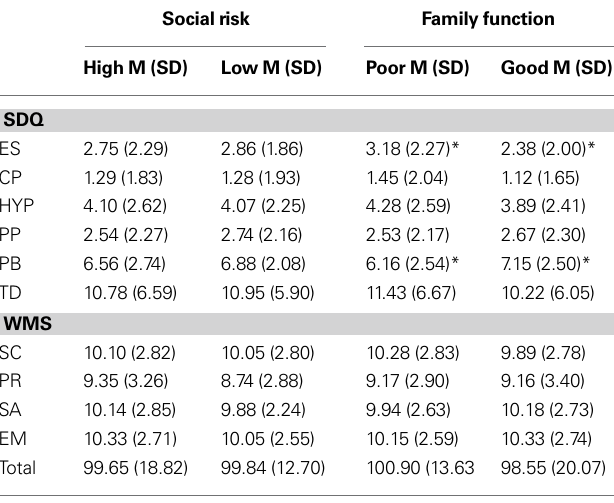
Table 6 | Differences in social functioning ratings for environmental